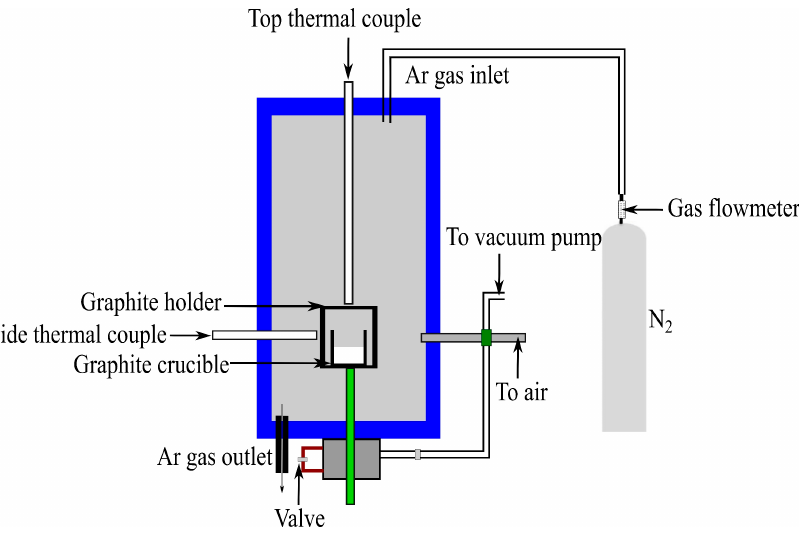
Figure 5. Schematic of the resistance vertical graphite tube furnace [31].